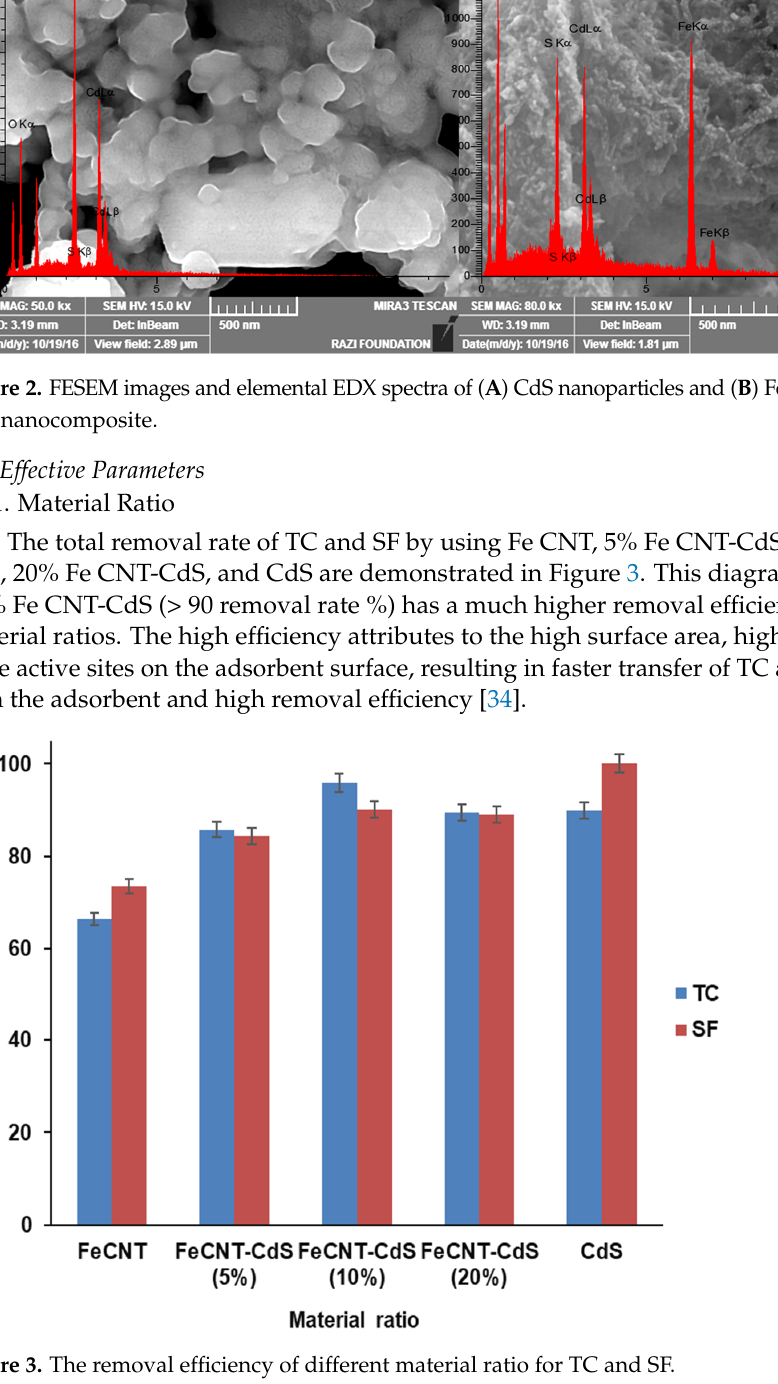
Figure 3. The removal efficiency of different material ratio for TC and